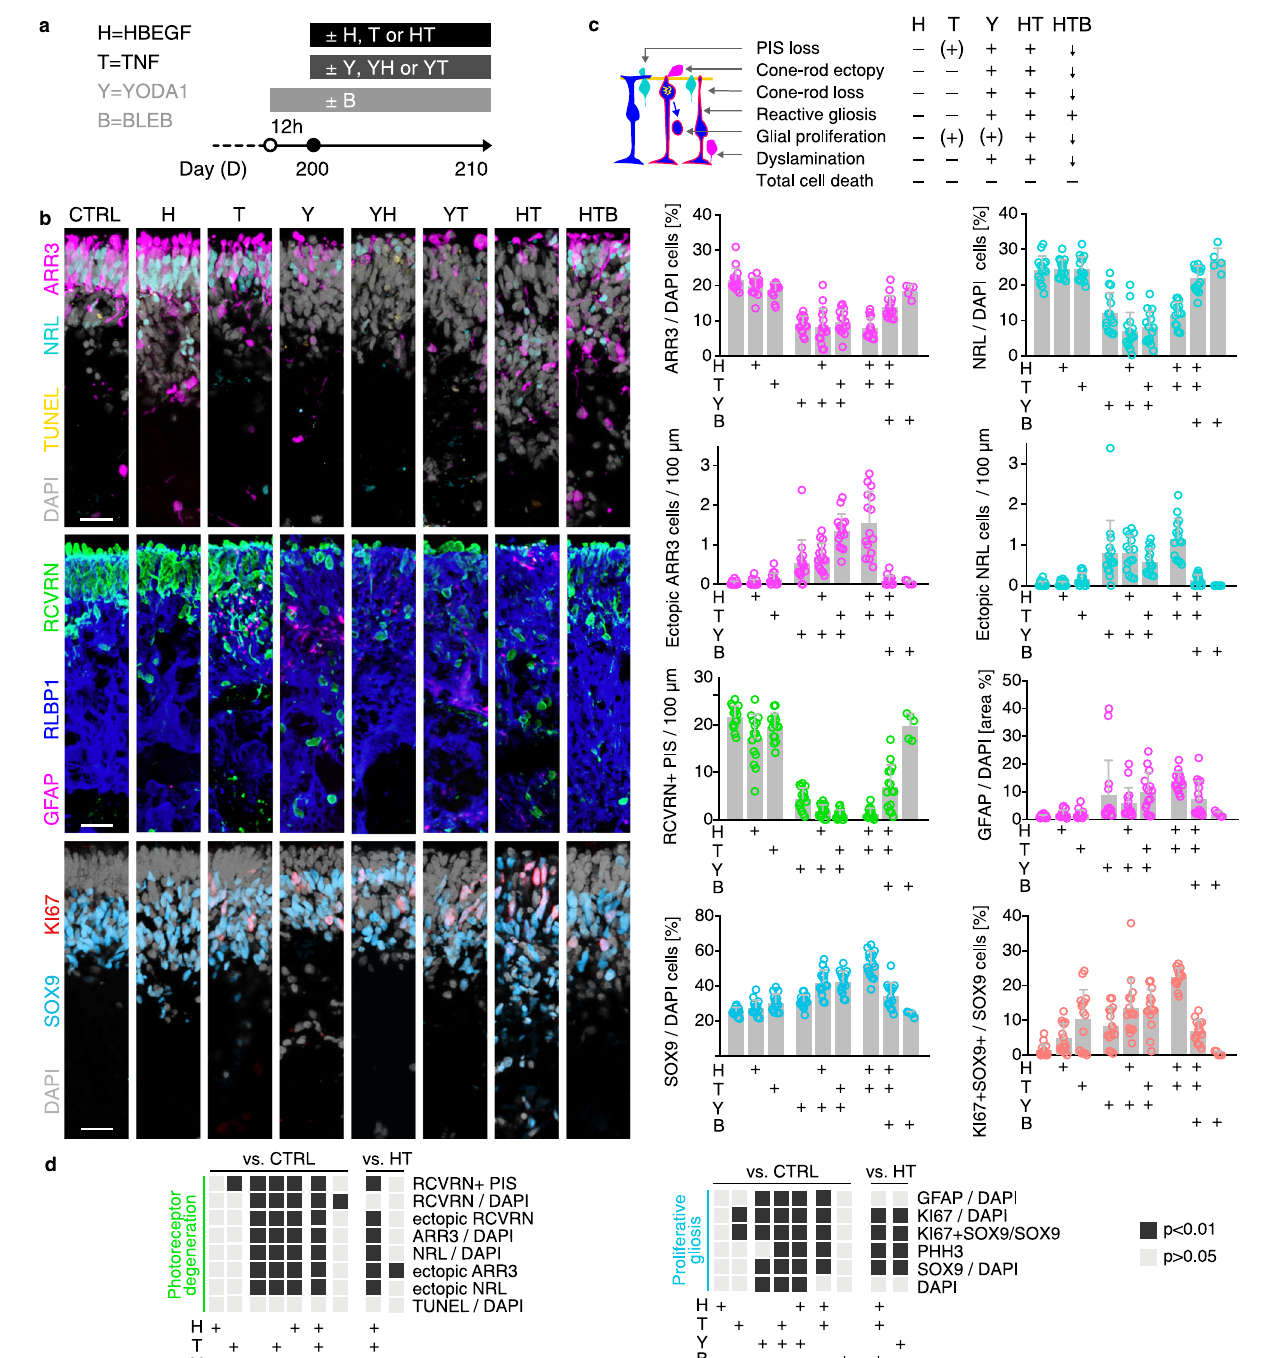
Fig.9|PIEZO1activatorYODA1issuf fi cienttoinducephotoreceptorextrusion, but single HBEGF or TNF is not. a Experimental design: starting from day 200, HROs were treated with PIEZO1-channel activator YODA1 (Y) alone, or in combi- nation with either HBEGF (H) or TNF (T). In addition, HROs were also treated with HBEGForTNFalone,orincombination(HT).( − )-Blebbistatin(BLEB,B),aninhibitor of myosin II, was applied to some HT-treated HROs starting 12h before HT appli- cation,andthenthroughouttheHTtreatmentperiod.HROswereanalyzedatD210. b Representative ROI images recorded from immunostained serial HRO sections and quantitatively analyzed to determine the effect of the treatments, including retinalcell-typecomposition,pathologicchangesofphotoreceptorinnersegments (PIS), cell death (TUNEL), glial proliferation, gliosis (GFAP), and MG delamination